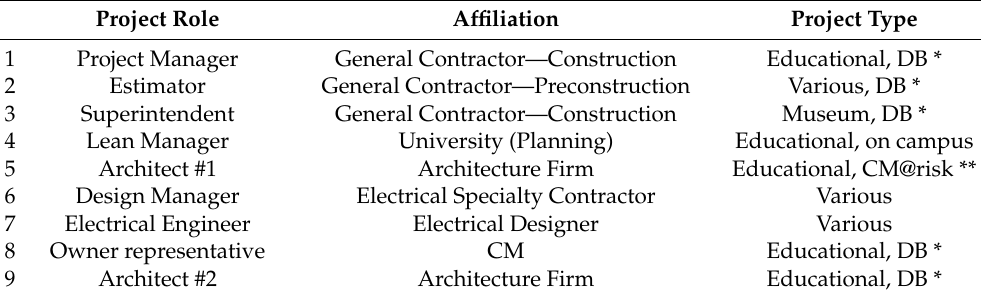
Table 2. Interviewees